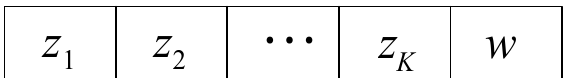
Figure 1. Individual encoding of the AFWDLMO